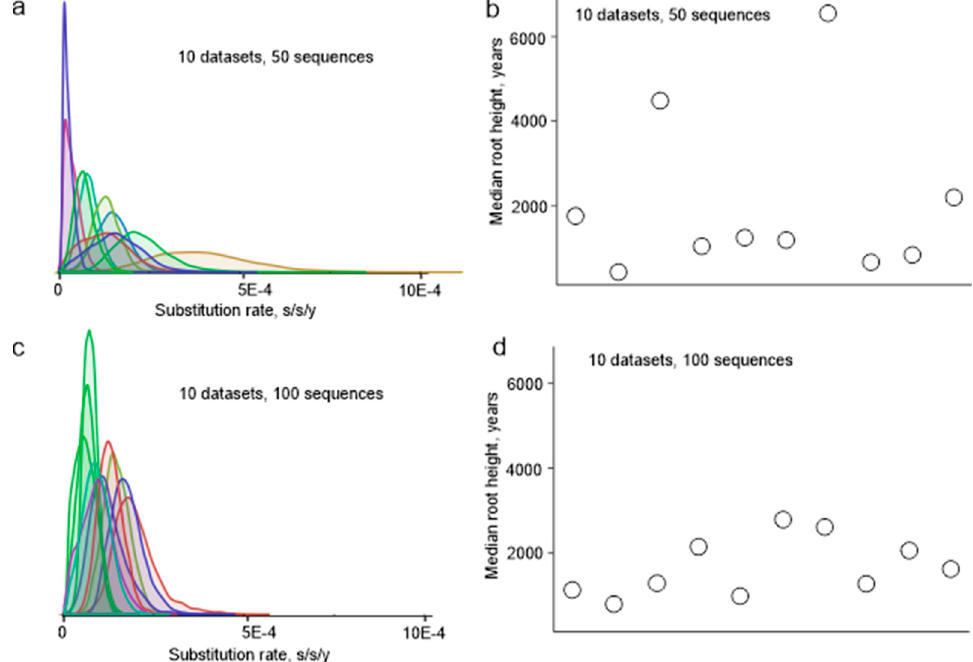
Figure 2. ( a ) Substitution rates among 10 random datasets (50 viruses each) of partial E protein sequences (1028 nt). ( b ) Root height in 10 random datasets (50 viruses each) of partial E protein sequences (1028 nt). ( c ) Substitution rates among 10 random datasets (100 viruses each) of partial E protein sequences (1028 nt). ( d ) Root height in 10 random datasets (100 viruses each) of partial E protein sequences (1028 nt).